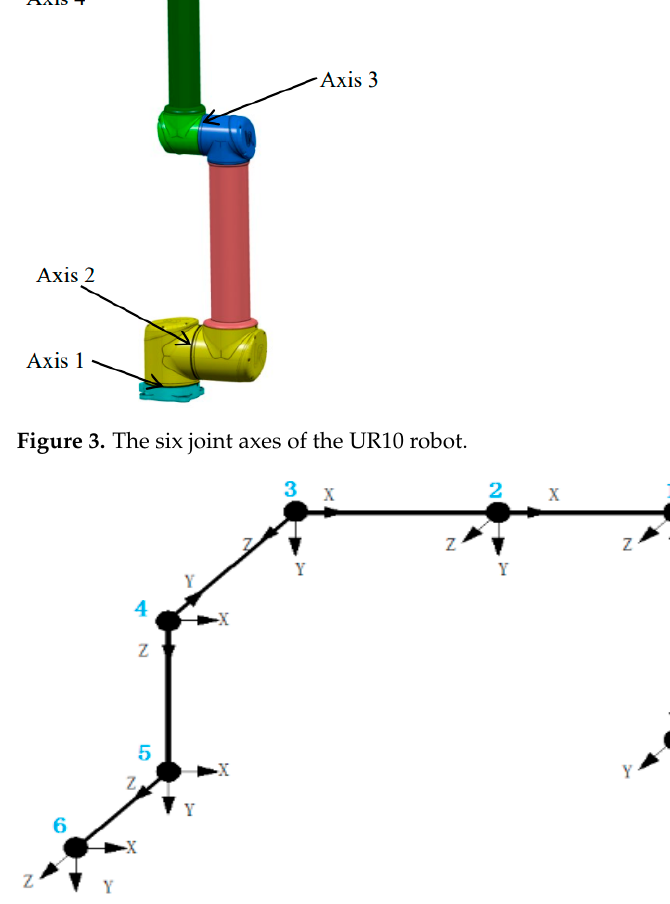
Figure 4. The pose diagram of the UR10 robot.